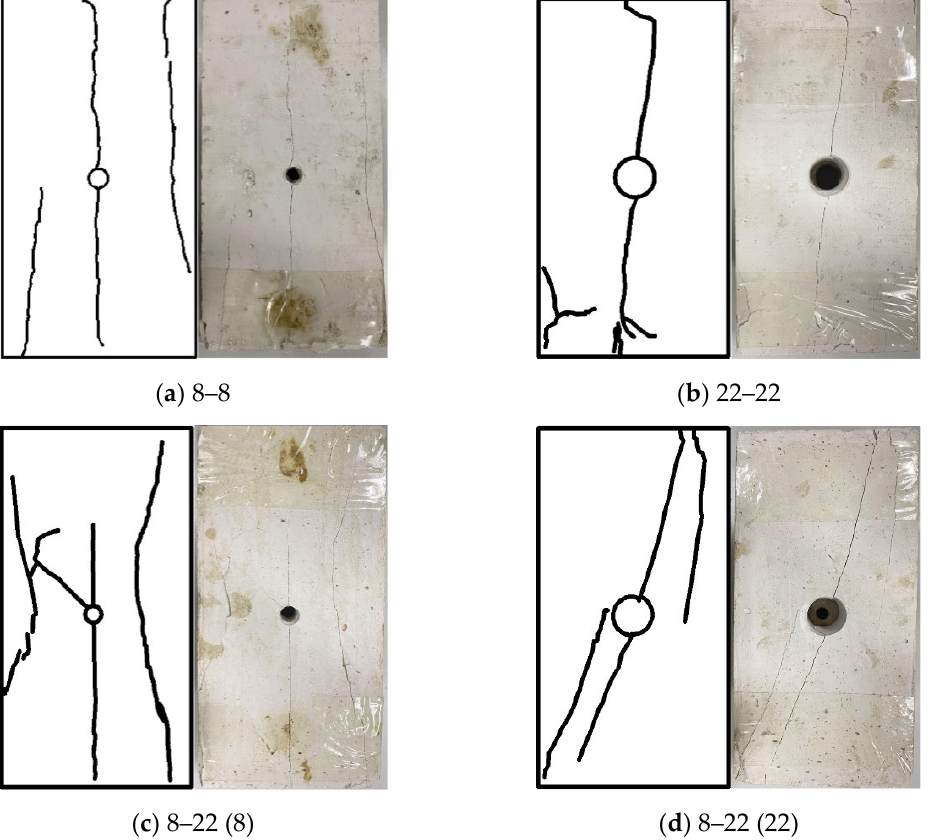
Figure 13. Crack propagation characteristics of Drilled samples of different sizes under different drilling